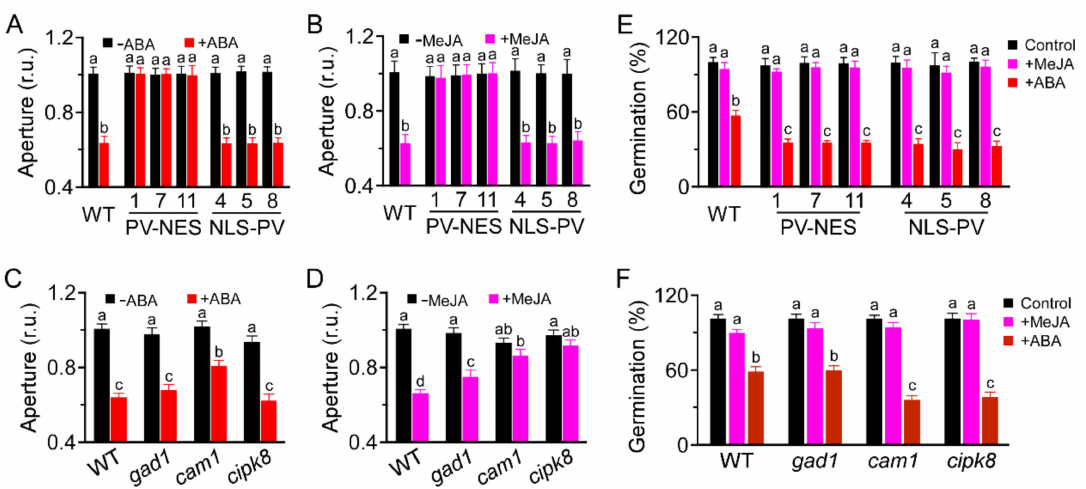
Figure 5. Impacts of [Ca 2+ ] cyt and [Ca 2+ ] nuc on ABA- or MeJA-induced stomatal closure and seed germination. ( A – D ) Stomatal apertures (W/L, width/length) of rosette leaves from 3-week-old WT, PV-NES , and PV-NLS plants, and gad1 , cam1 , and cipk8 plants, were measured after treatment with 10 µ M ABA ( A , C ) or 50 µ M MeJA ( B , D ). r.u. indicates relative units. Data from six independent experiments and a total of 120 stomata are shown; data are shown as means ± SDs. Different letters indicate statistical significance at p < 0.05 (Student’s t -test). ( E , F ) Seed germination of WT, PV-NES , and PV-NLS transgenic lines ( E ) and of WT, gad1 , cam1 , and cipk8 plants ( F ) in response to ABA or JA treatment. Seeds were plated on half-strength MS plates containing ABA (10 µ M) or MeJA (50 µ M) for 3 days at 4 ◦ C in the dark, then transferred to a growth chamber under 16 h light (120 µ mol m − 2 s − 1 )/8 h dark at 22 ◦ C for another 3 days. Error bars represent SDs; n = 600 seeds. Different letters indicate significant differences at p < 0.05 (Student’s t